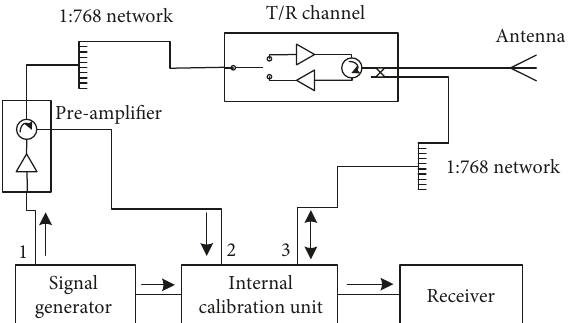
Figure 3: Schematic diagram of the directional coupler in the T/R